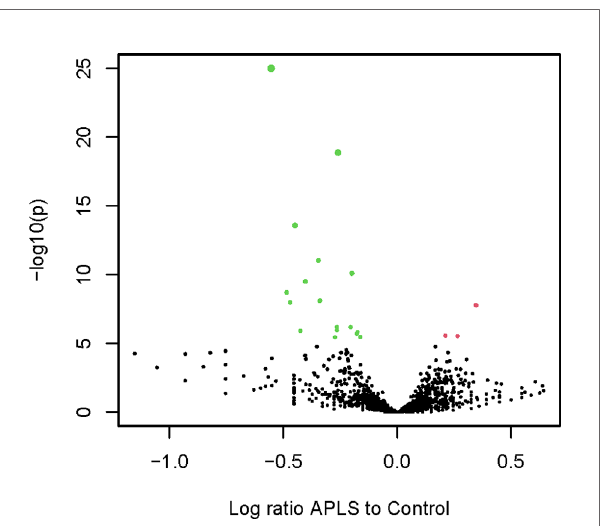
FIGURE 7 | Volcano plot illustrating the differential representation of control or APS speci fi c mimotope sequences in each cluster of sequences in the signi fi cant neighborhood graph (red – A or green - C